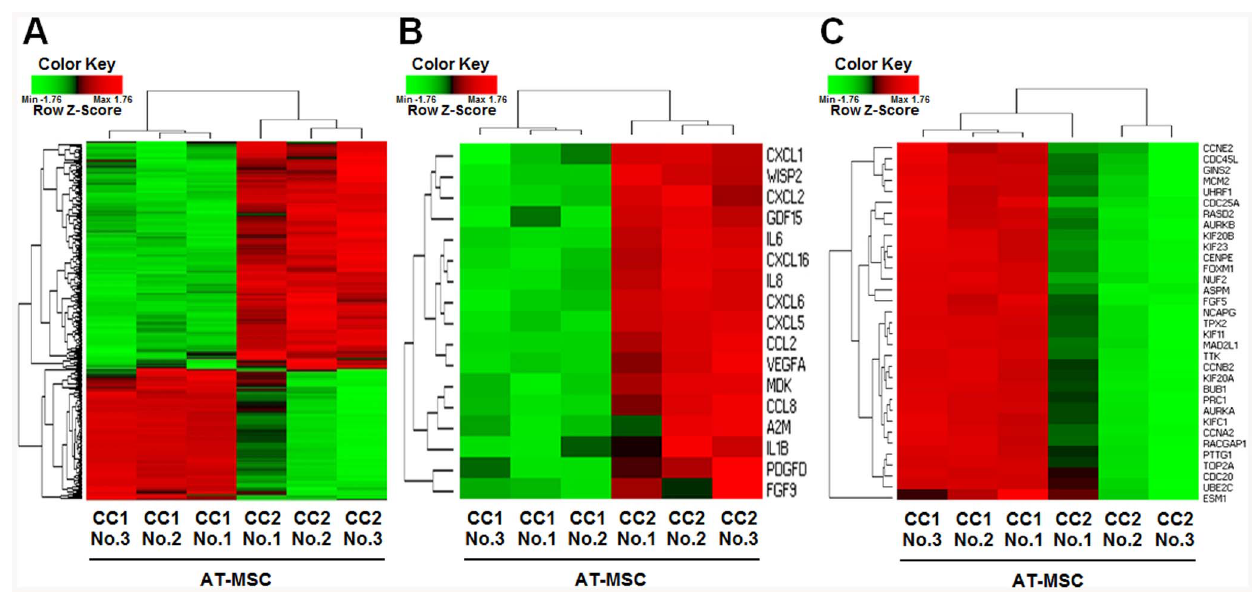
Figure 3. Hierarchical cluster analysis of differentially expressed genes in AT-MSCs from three different donors in CC1 or CC2. The microarray data for 47,323 genes were filtered by applying two criteria for significance, P , 0.05 and fold change (FC) . 2, between the two cell densities (CC1 and CC2) at harvest for each MSC donor. ( A ) The selected data represented by hierarchical clustering of the normalized Ct of 279 genes on MSCs using individual samples (177 with increased expression, 102 with decreased expression). Each row represents a single gene, while each column represents the gene expression levels for a cell culture. The color coded gene expression levels range from red for the highest level of expression to green for the lowest. ( B ) Hierarchical cluster analysis of 17 differentially expressed cytokine, chemokine and growth factor genes. ( C ) Hierarchical cluster analysis of 33 differentially expressed proliferation-associated genes. CC1, cultures plated with an initial cell density of 200 cells/ cm 2 and a culture duration of 7 days; CC2, cultures plated with an initial cell density of 5,000 cells/cm 2 and a culture duration of 7 days.